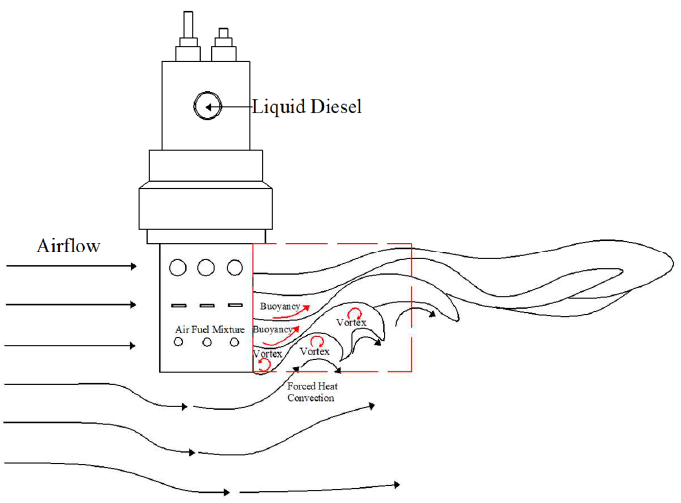
Figure 6. The physics of burner flame.